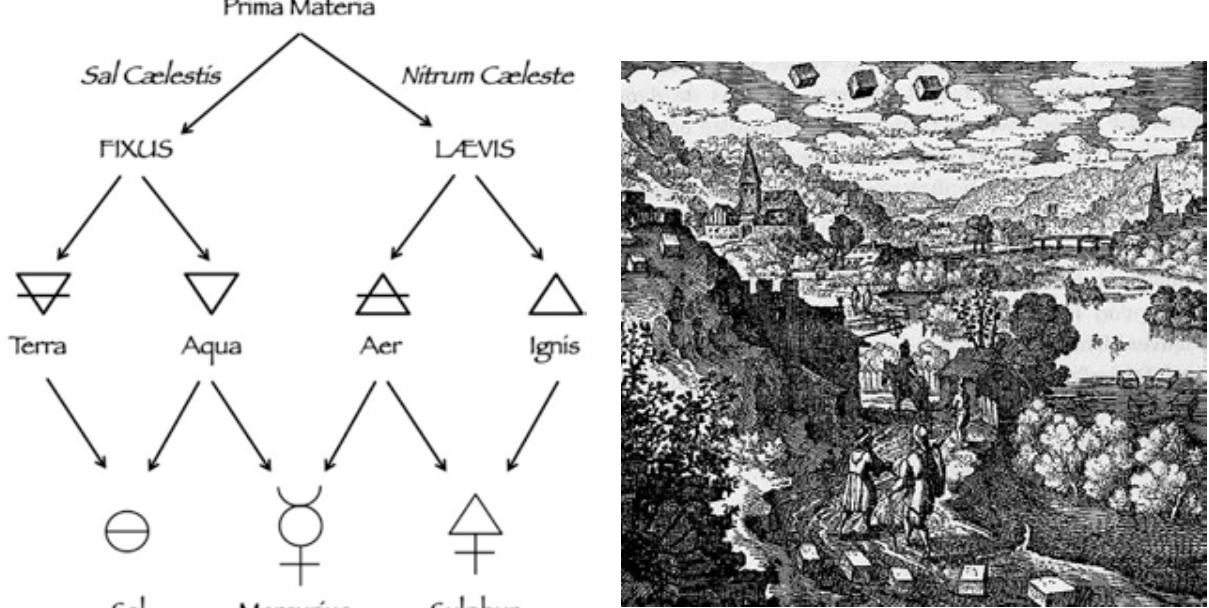
Figure 2. A picture of the unitary alchemical cosmology.